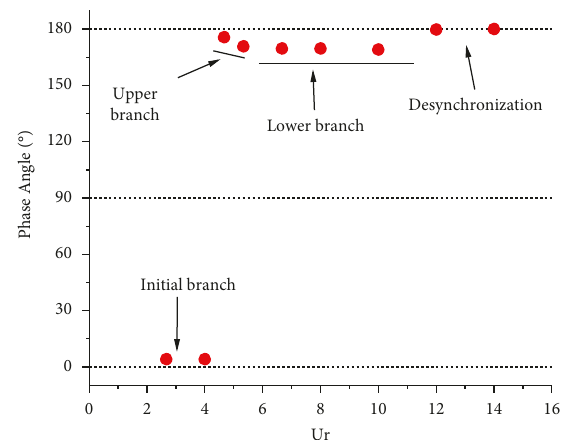
Figure 11: Phase angle between the lift force and the cylinder displacement.